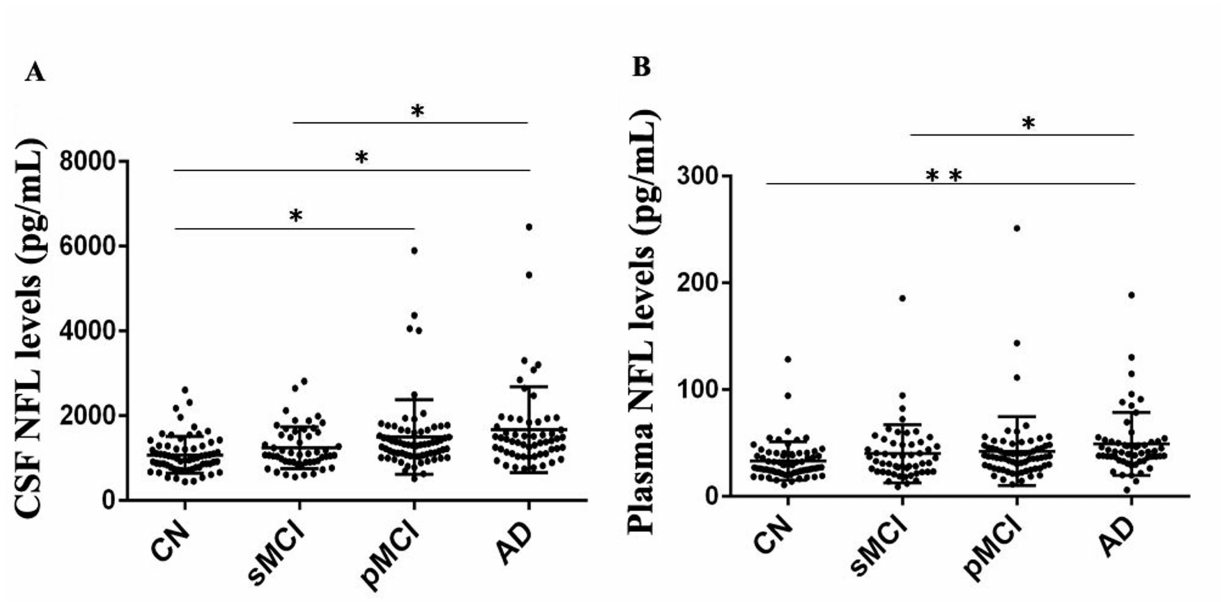
Fig. 1. The levels of CSF and plasma NFL in different groups. The levels of CSF NFL (A) and plasma NFL (B) in different groups. Differences among groups were detected by multiple-variable linear regression. * p < 0.05; ** p < 0.01.